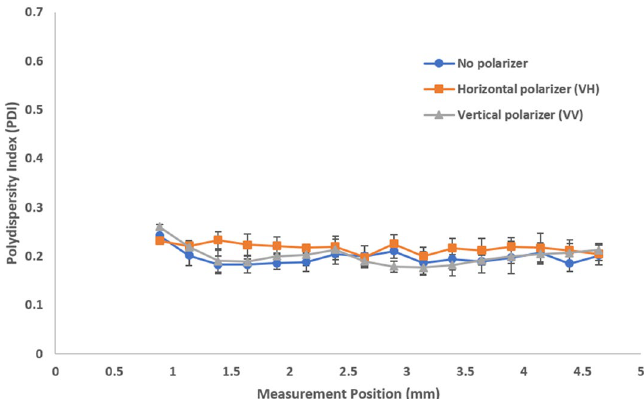
Figure 8. Polydispersity index (PDI) as a function of measurement position shows the absence of multiple scattering with different polarizer configurations for 1000-fold diluted milk. Single scattering shows consistent and lower PDIs regardless of polarizer configuration.